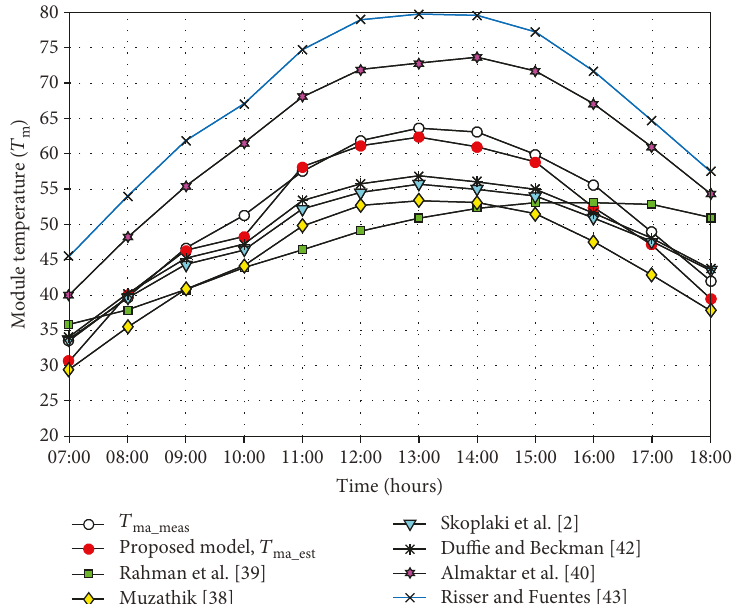
Figure 14: Proposed model estimation versus measured data and other existing model module temperature values of amorphous module during summer.